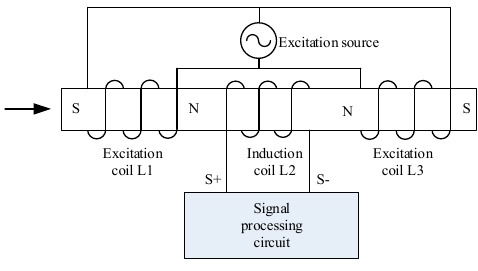
Figure 1. Schematic of the three-coil induction abrasive particle sensor .